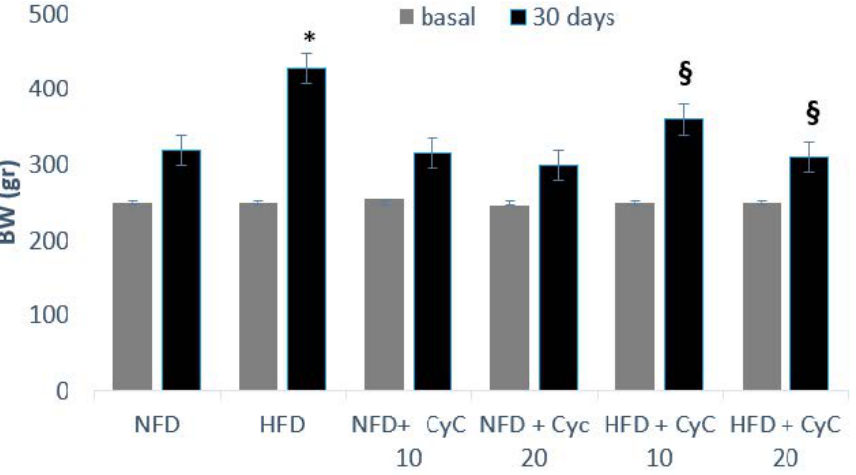
Figure 2. The effect of CyC (10 and 20 mg/kg daily given orally over a period of four weeks) on body weight in Normal Fat Diet (NFD) and High Fat Diet (HFD) groups. Data are expressed as mean ± SE.* P < 0.05 HFD vs. NFD. § P < 0.05 HFD + CyC vs. HFD.